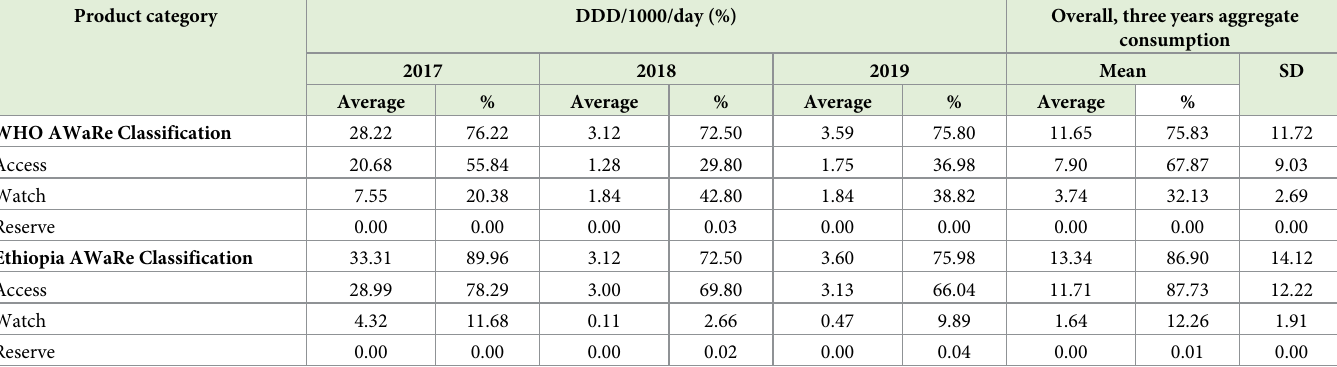
Table 4. Antimicrobial consumption by AWaRe classification from 2017–2019 in Ethiopia. Product